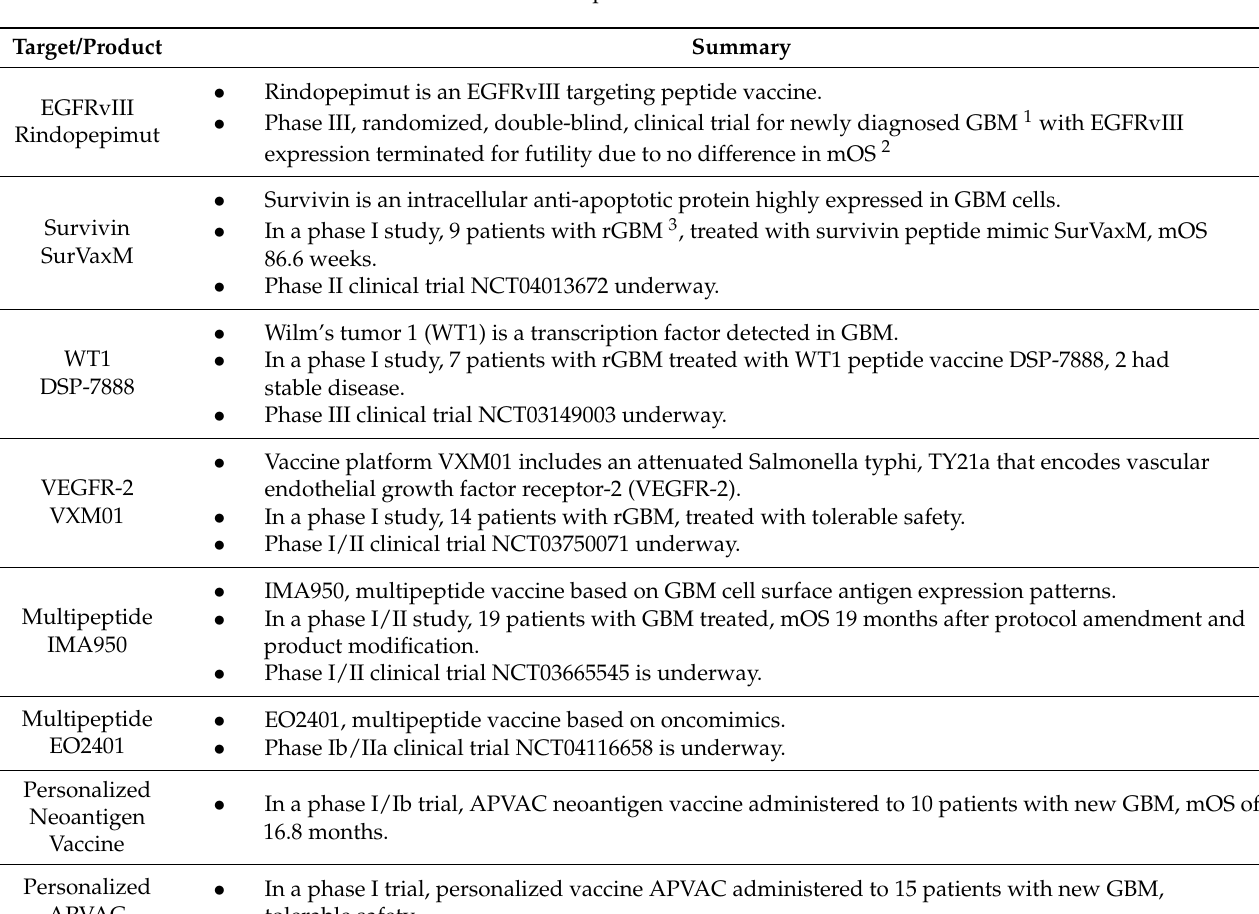
Table 3. Vaccine-Based Therapies in